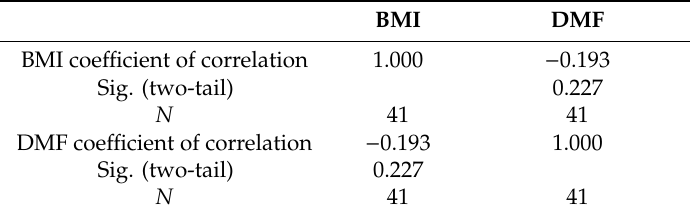
Table 12. Data related to the correlation between BMI and DMF in patients with a Class I molar relationship.